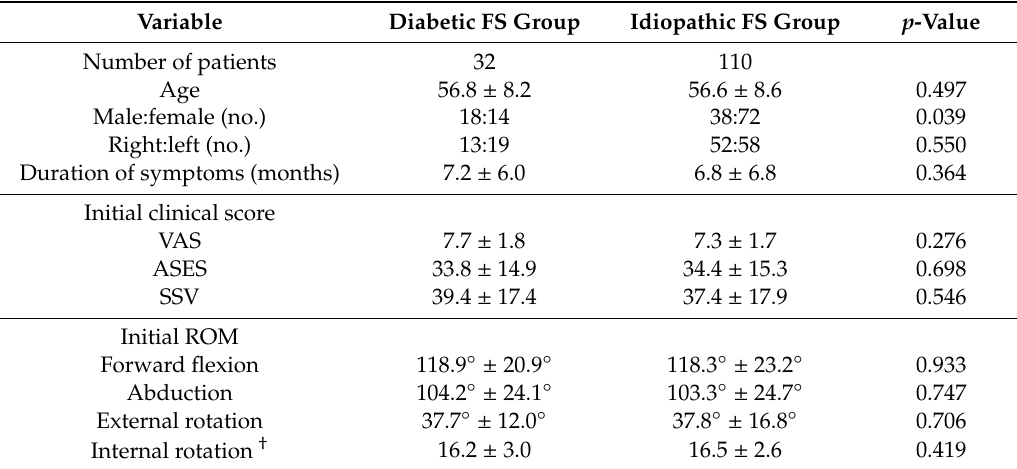
Table 1. Baseline demographics of patients with diabetic or idiopathic